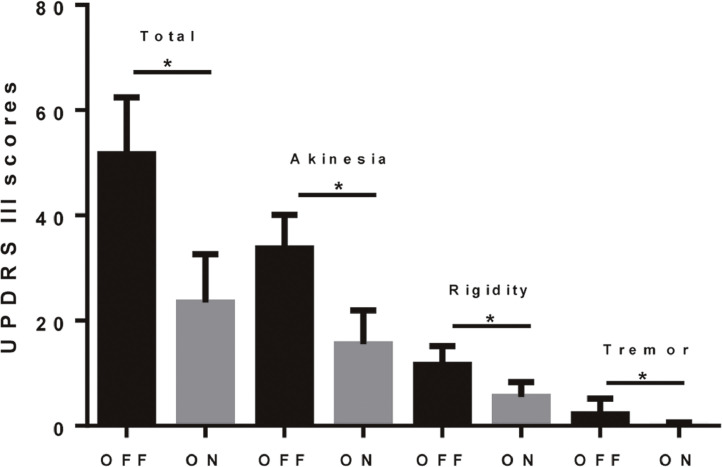
L-dopa significantly alleviated the motor symptoms of PD patients. The asterisks indicate p < 0.0001 in a paired t-test. The improvement in UPDRS III was 55% in total score, 54% in akinesia, 53% in rigidity and 93% in tremor.